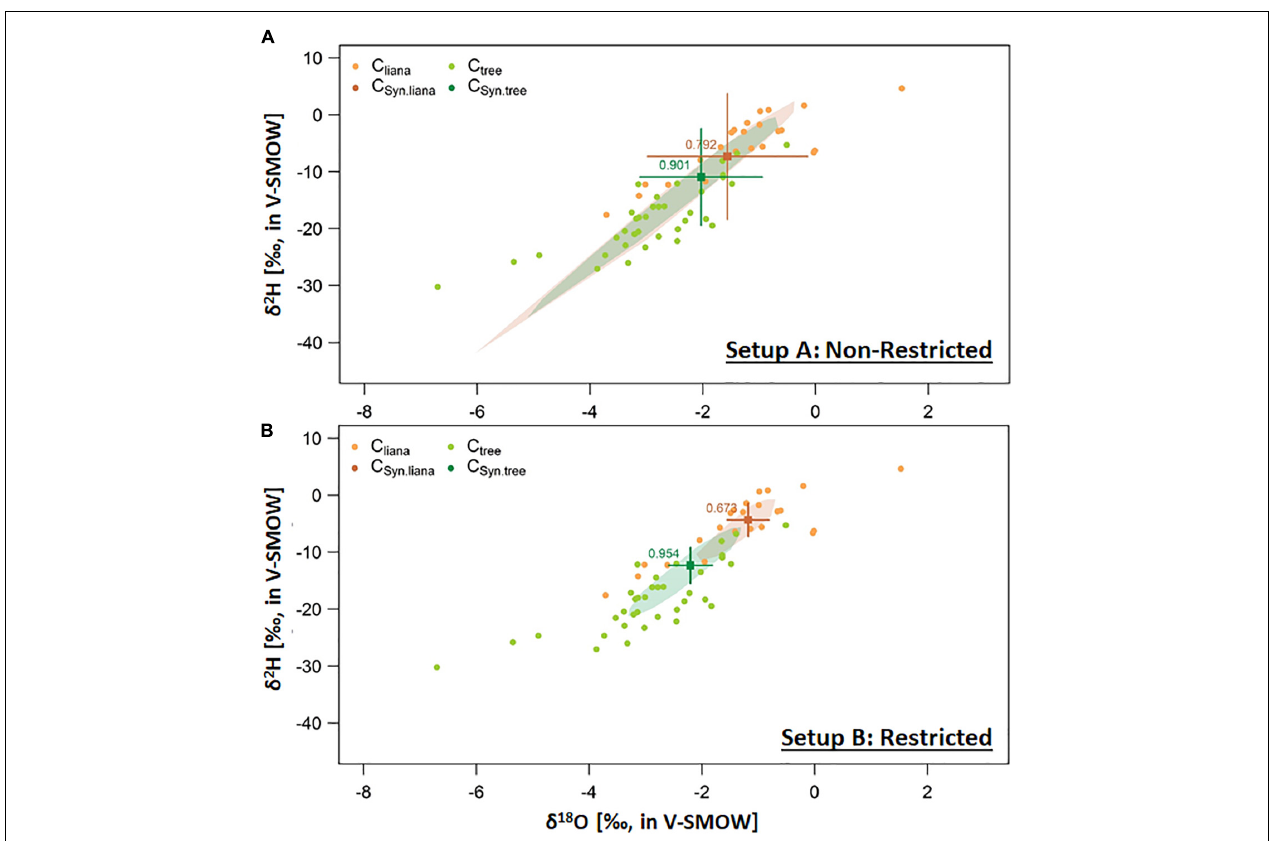
FIGURE 6 | Dual isotope plot representation of the xylem water isotope compositions ( δ xyl ) of trees (C tree , • ) and lianas (C liana , • ) obtained in Laussat, French Guiana, in 2017. Setup (A ) Study setup which ignored restriction in soil water potential measurements, i.e., (cid:57) S and Setup (B) Study setup with a more superior characterization of (cid:57) S . Mean ± 2x standard error of simulated δ xyl provided for the mean b β of 10 independent optimization assessments (i.e., P ( δ xyl | b β , χ ) ), provided for trees (C Syn . tree , ) and lianas (C Syn . liana , ). Corresponding convex hulls shows the pooled simulated δ xyl range for all 10 independent optimizations. Applied parameterization is provided in Supplementary Table 3 . Mean optimized b β values are provided in respective colors. Related standard error confidence intervals are provided in Table 2 .